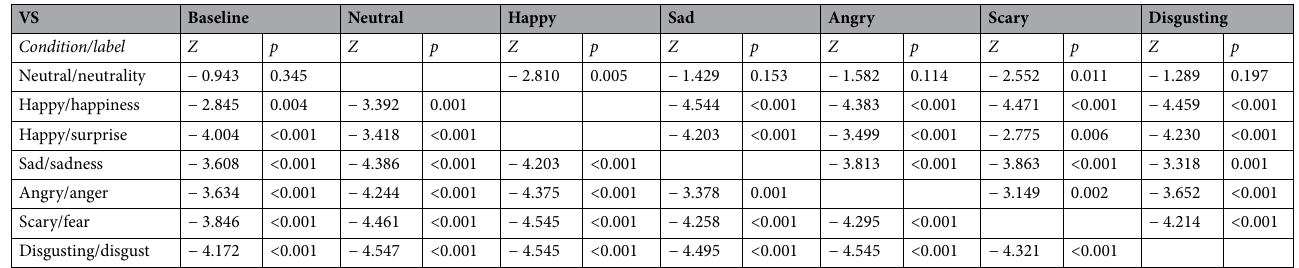
Table 2. Exp. 2—comparison of each label in the condition with the highest rating and all other